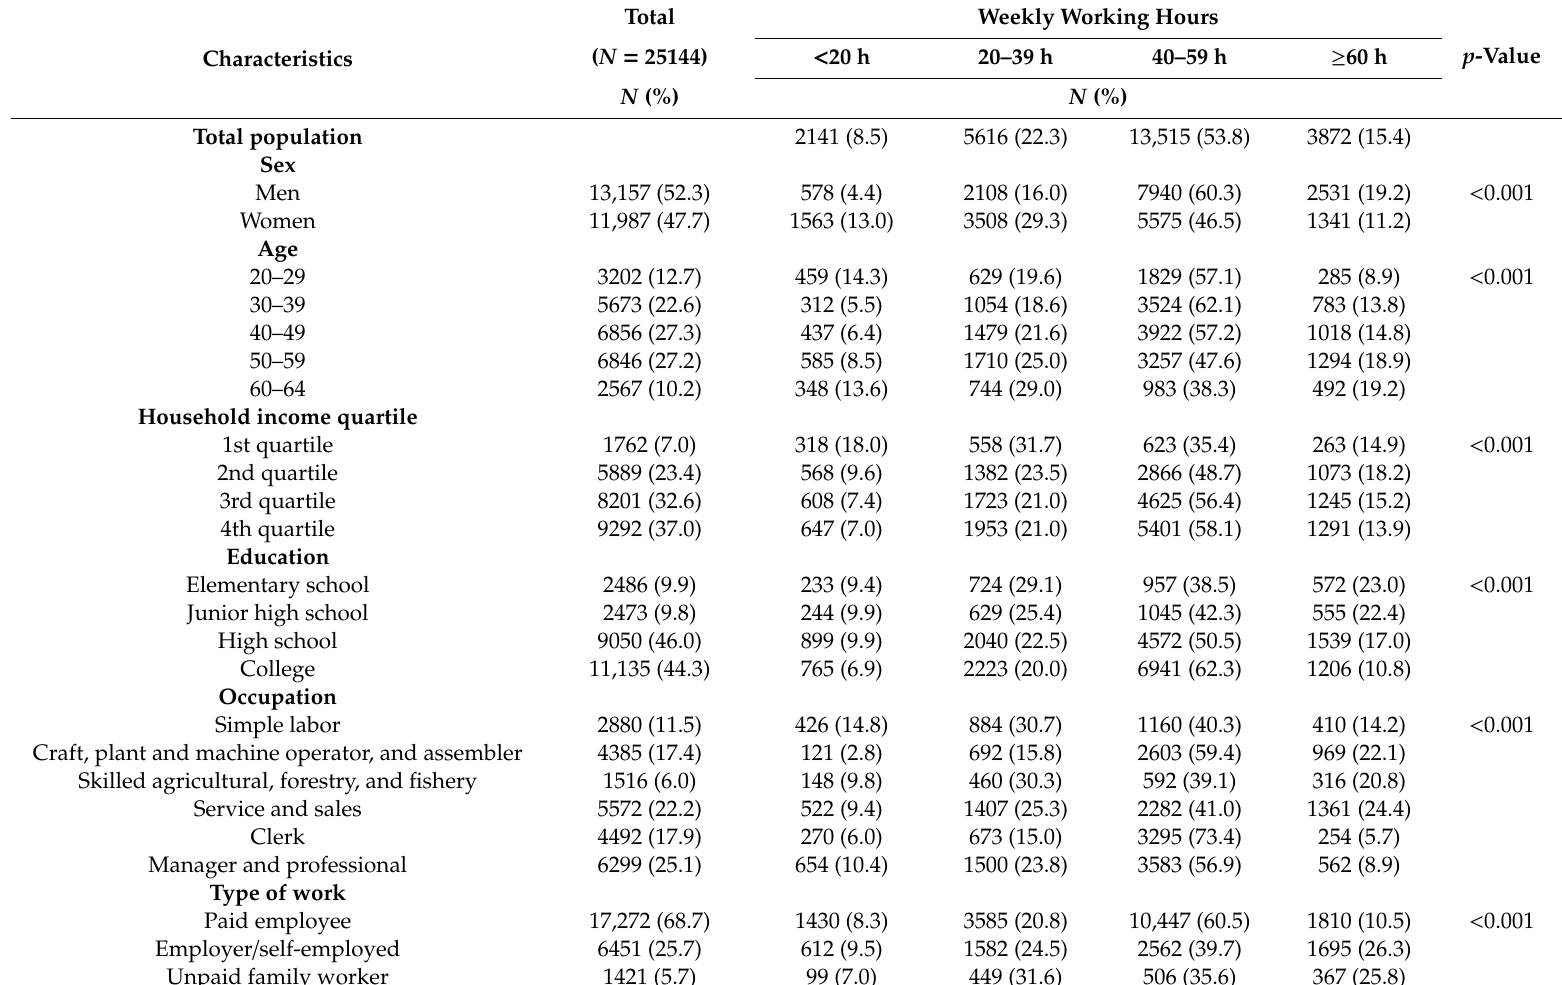
Table 1. General characteristics of study participants by weekly working